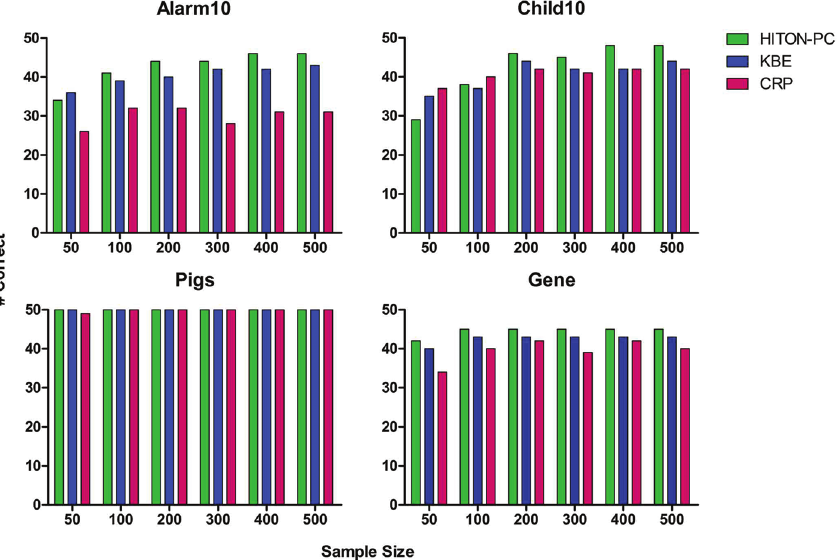
Figure 1: The number of times HITON-PC, KBE, and CRP correctly detected a single variable in 50 Markov boundaries across four expert-designed discrete Bayesian networks. HITON-PC and KBE outperform CRP by a small margin across most sample